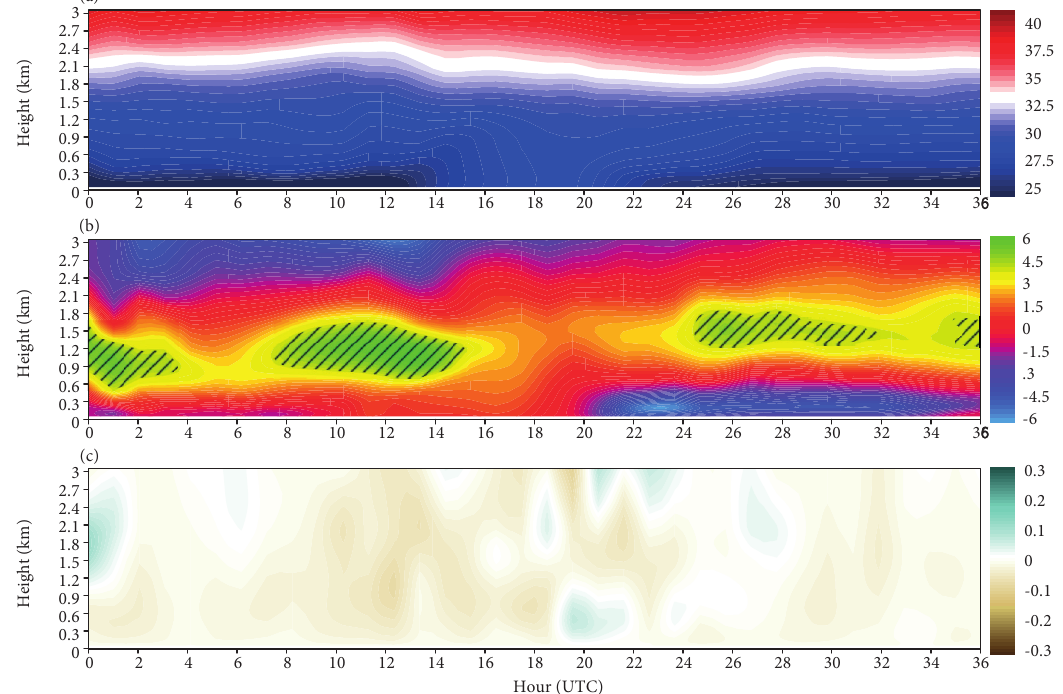
Figure 9. Temporal evolution along transect CD for potential temperature (a), meridional wind (b), and vertical velocity (c). The hatched areas represent maximum values from 4.5 to 6 m.s -1 in the meridional component of the